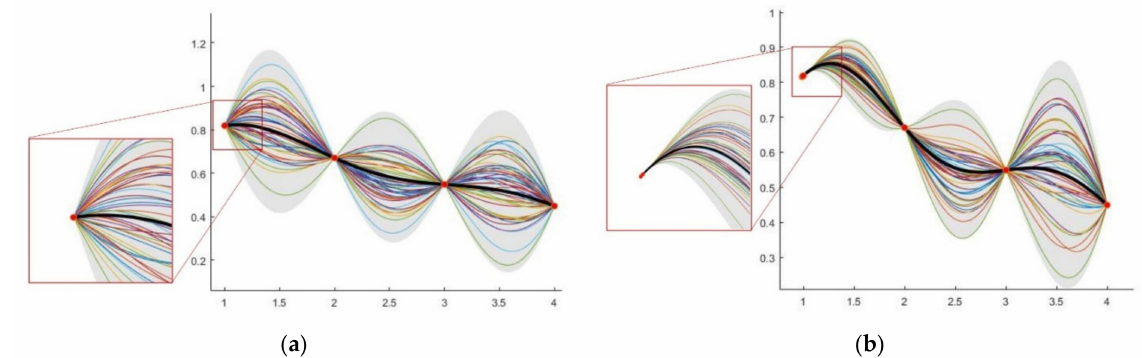
Figure 3. The local paths sampled from the GRPS method, where the red points are waypoints, color curves represent random paths, and the shadow is the sampling range of 99.74% random paths.